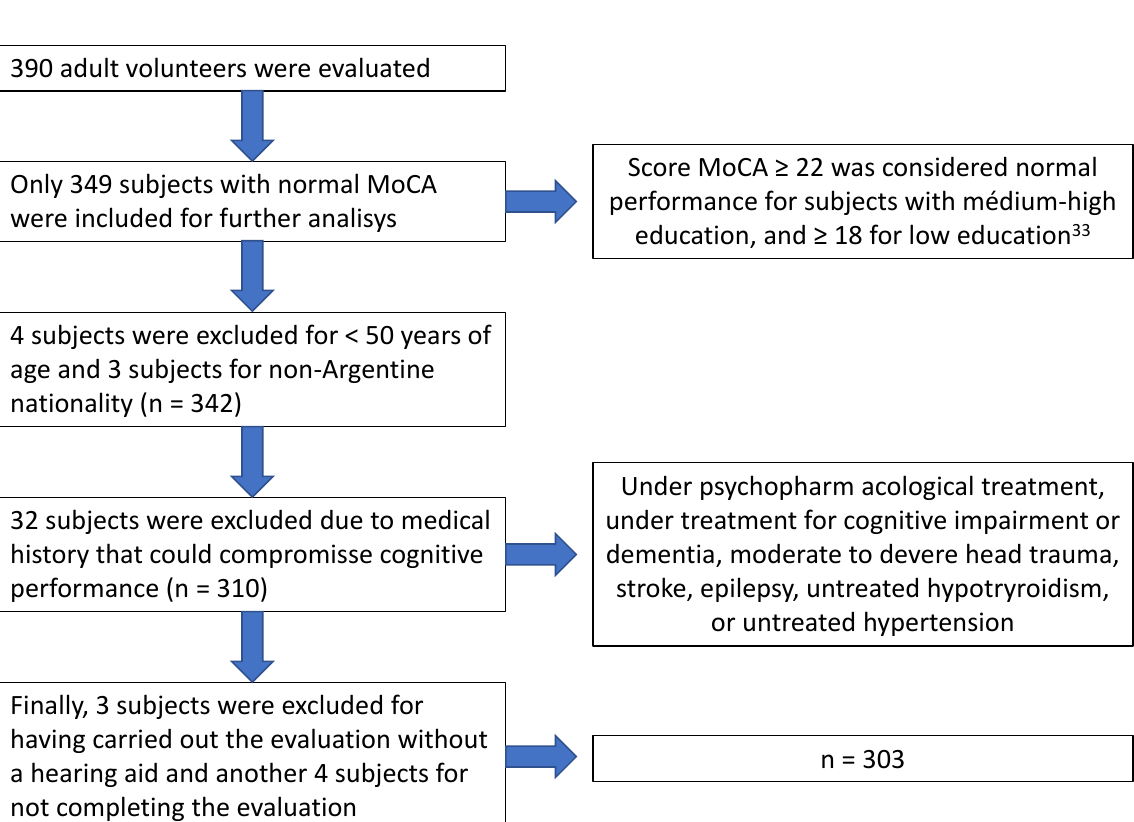
Figure 1. Participant selection criteria and